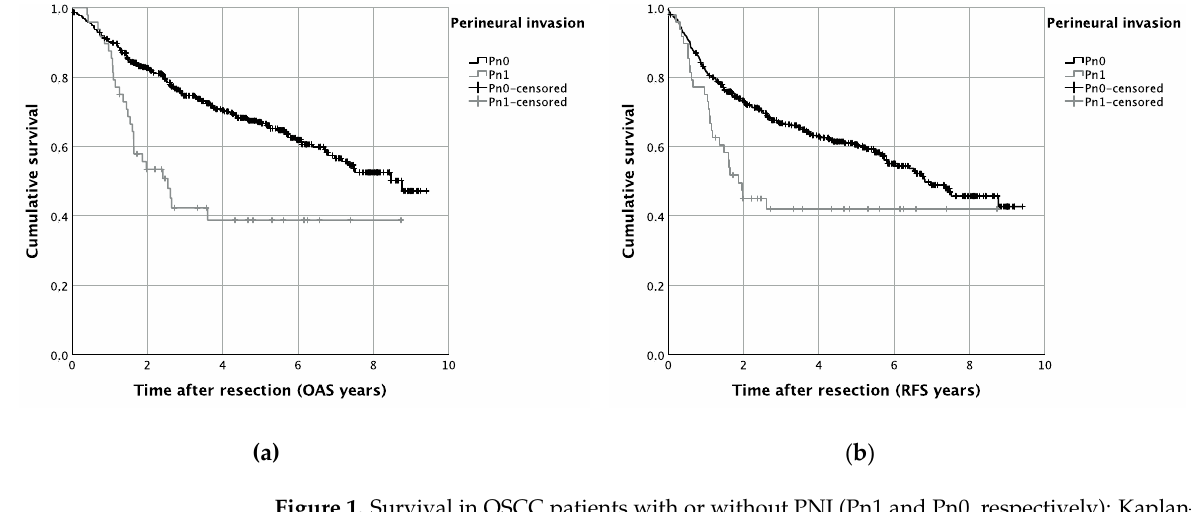
Figure 1. Survival in OSCC patients with or without PNI (Pn1 and Pn0, respectively): Kaplan–Meier curves for OAS ( a ) ( p = 0.001) and RFS ( b ) ( p = 0.002). Table 2. Cumulative recurrence rates of as well as detailed forms of recurrence in OSCC patients, Multivariable survival analysis was additionally performed to adjust for covariables depending on such as gender, ACCI, smoking and alcohol consumption, anatomical tumor site, UICC stage, grading, and lymphatic and vascular invasion. For OAS, a pathohistological verifi-